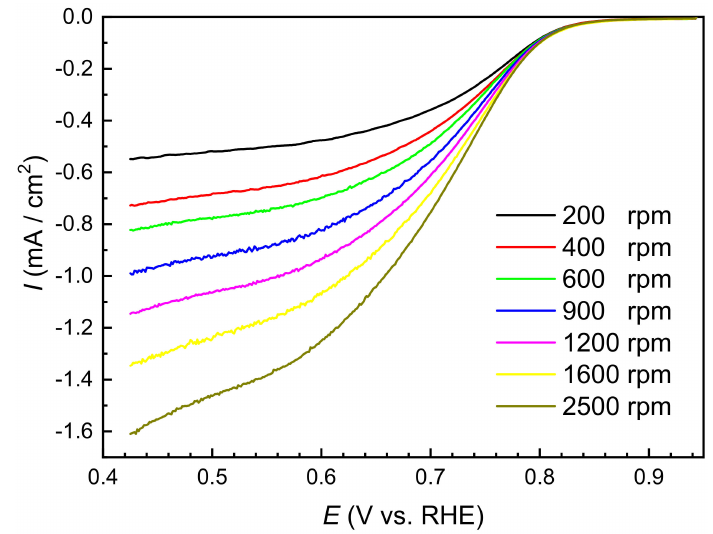
Figure 2. The LSV curves of the Ni(dto)-DH/C electrode recorded at a scan rate of 5 mV/s in the oxygen-saturated 1 M KOH solution at different electrode rotation speeds.